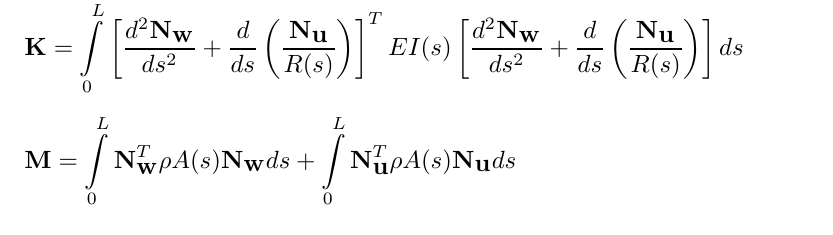
Fig. 2. Nodal degrees of